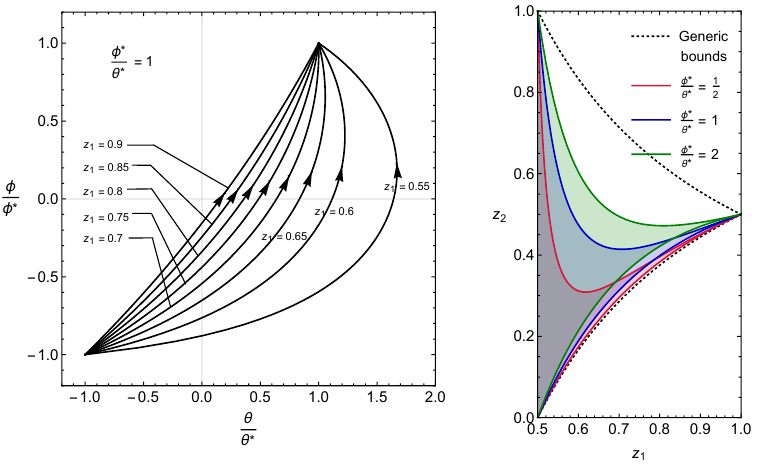
(cid:3) =# (cid:3) = 1 is mapped out. The (cid:3) =# (cid:3) . The generic